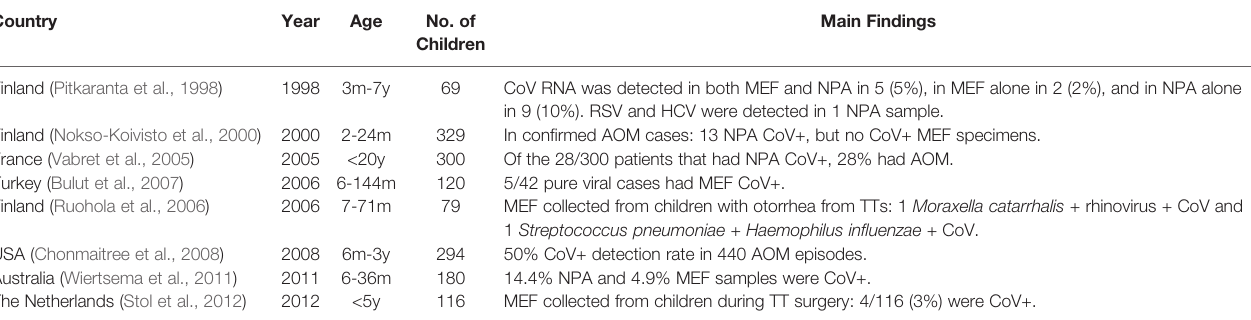
TABLE 1 | CoV detection in AOM